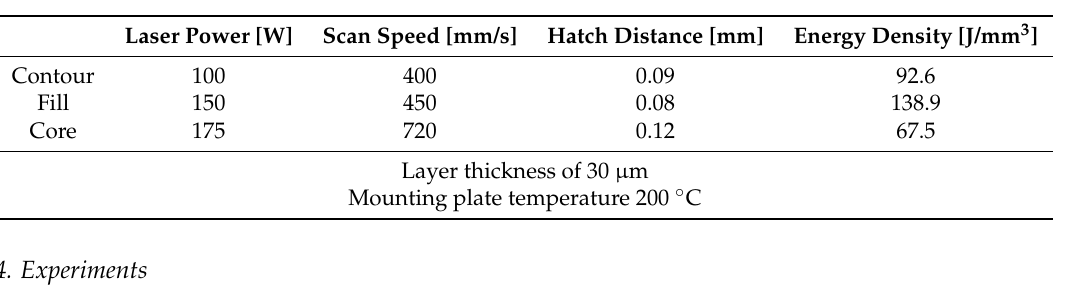
Table 2. Parameters used in this work for additive manufacturing of H13 tool